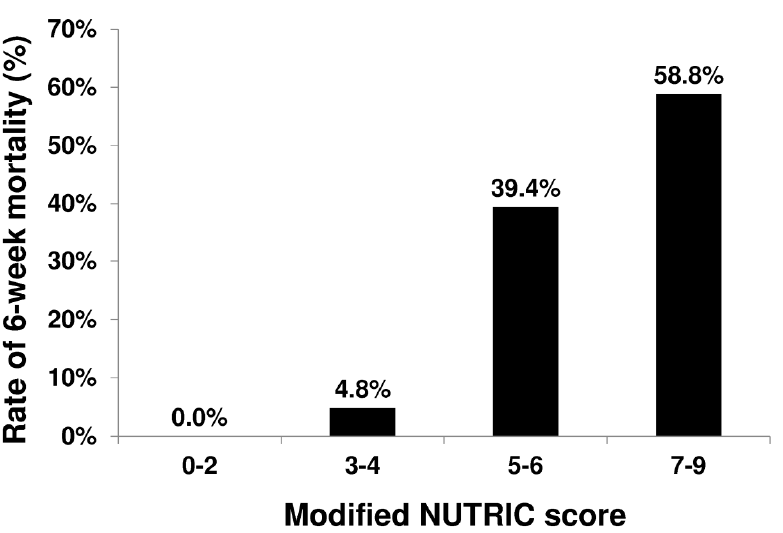
Figure 2. Relationship between 6-week mortality and mNUTRIC score ( χ 2 for trend, p <0.001). Table 1. Patients’ demographic data and clinical characteristics grouped according to 6-week mortality.